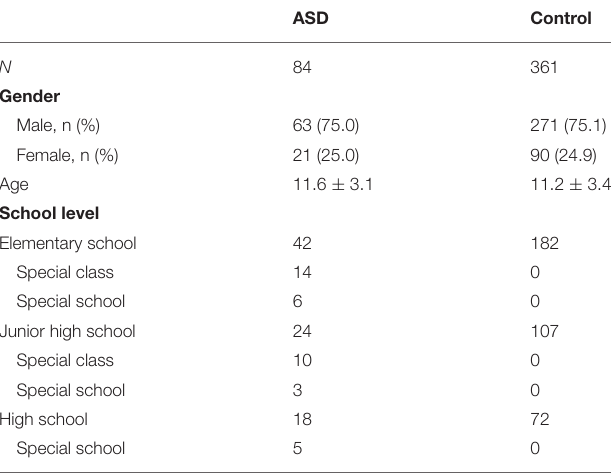
TABLE 1 | Characteristics of the participants. ASD